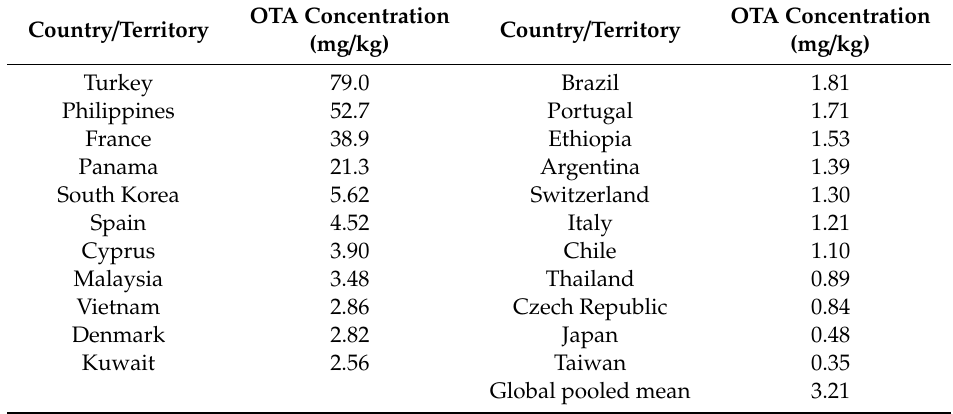
Table 1. Ranked order of countries on the basis of mean concentration of ochratoxin A (OTA; mg / kg)